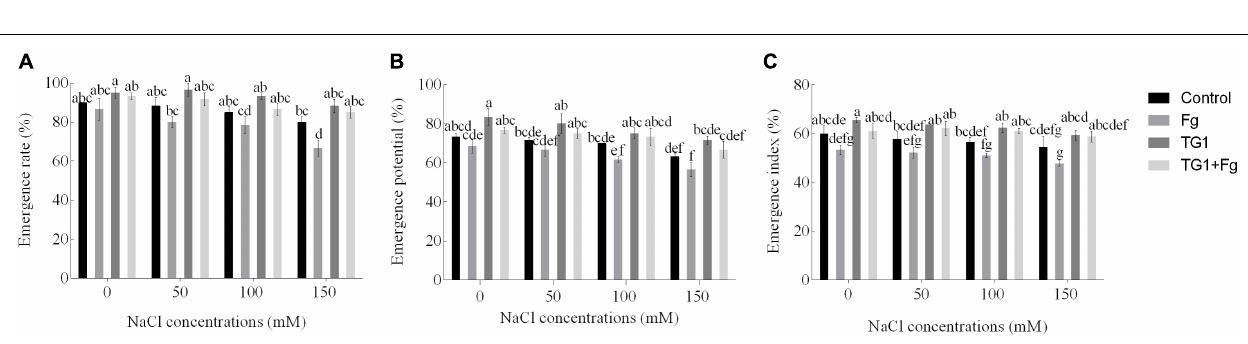
FIGURE 4 | Relative expression levels of (A) β -1, 6-glucan synthase (PP4), (B) endochitinase (PH-1), and (C) endochitinase (chi18-15) genes were measured by qRT-PCR during the interaction of T. longibrachiatum (TG1) and F. pseudograminearum (Fg) in a dual plate assay at 150 mM salt stress. Gene expression was evaluated at three different interaction time points at Days 3 (T1), 7 (T2), and 14 (T3) after the interaction. The 2 − (cid:49)(cid:49) ct method was used for the relative expression of each target gene using the control and α -tubulin as the reference gene. Small bars represent the standard errors of the means. Different lower case letters indicate significant differences at P < 0.05 in Duncan’s multiple range test using two-way ANOVA.